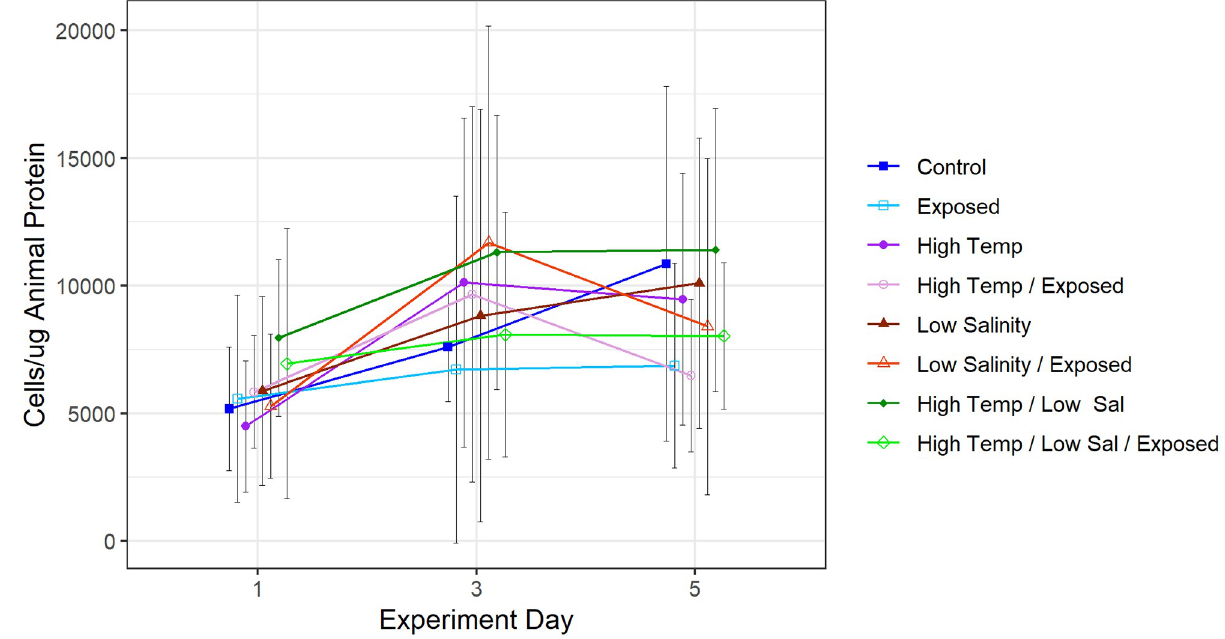
Fig 7. Pulsed 3-Stressor Experiment results. N = 5 per point. Error bars show ± CI. No treatment combination showed significant differences in symbiont abundance compared to other combinations. All treatment combinations appeared to increase slightly between Experiment days 1 and 3.